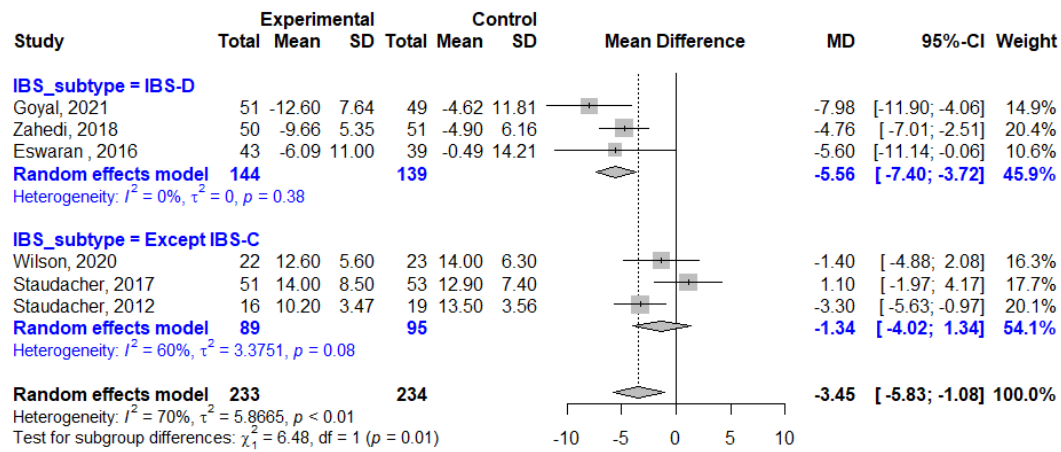
Figure 7. Forest plot showing mean differences in average weekly stool frequency. SD, standard deviation; MD, mean difference; CI, confidence interval.